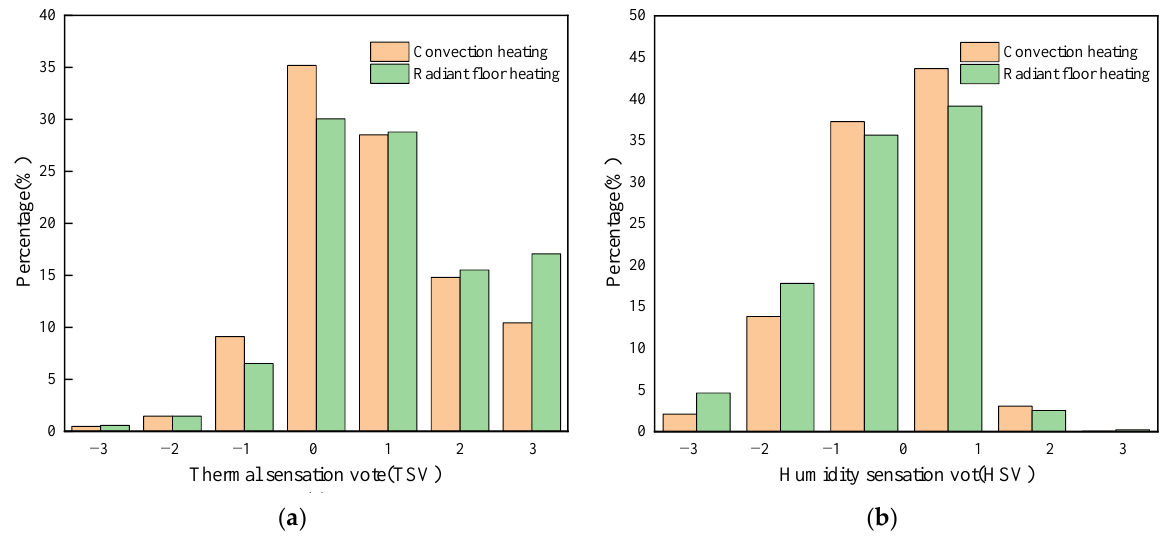
Figure 5. Distribution of the subjective thermal responses: ( a ) TSV, ( b ) HSV. Humidity Sensation Vote